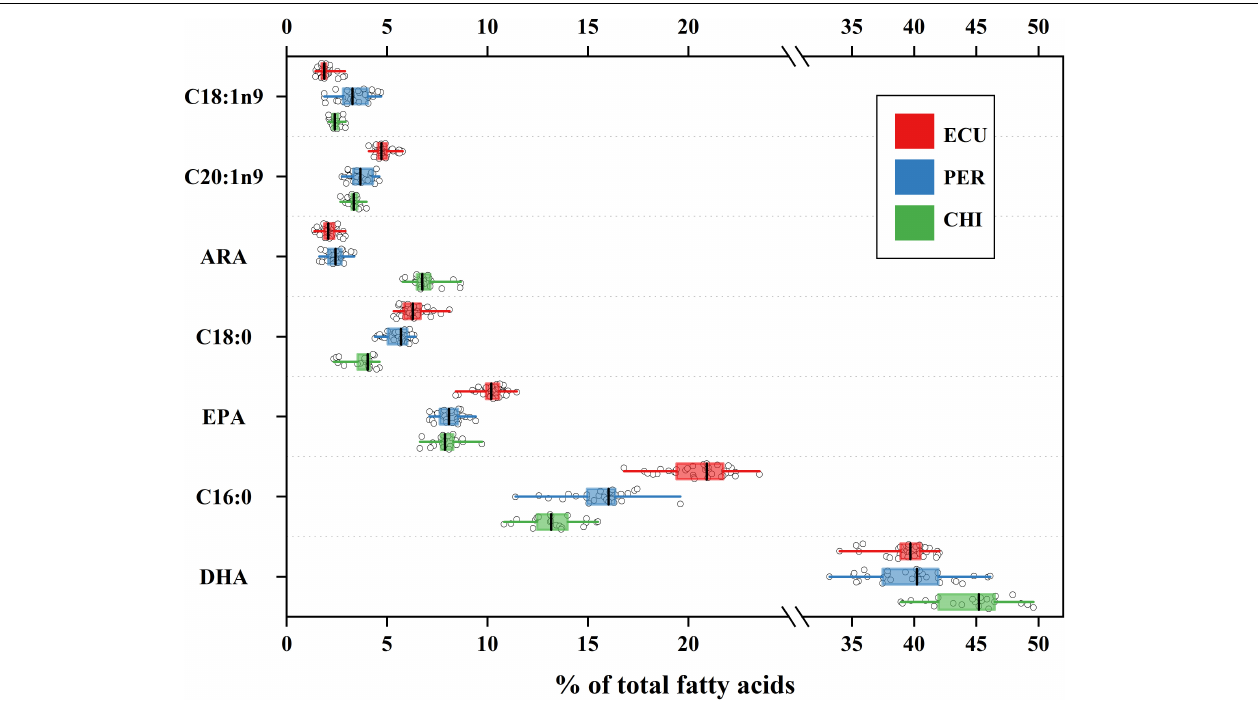
FIGURE 2 | Variation in fatty acid profiles of Dosidicus gigas relative to three geographic areas. Mean values are shown with error bars of standard deviations. The box represents the interquartile range and vertical line within each box represents median value. Whiskers indicate minimum and maximum values. ARA, arachidonic